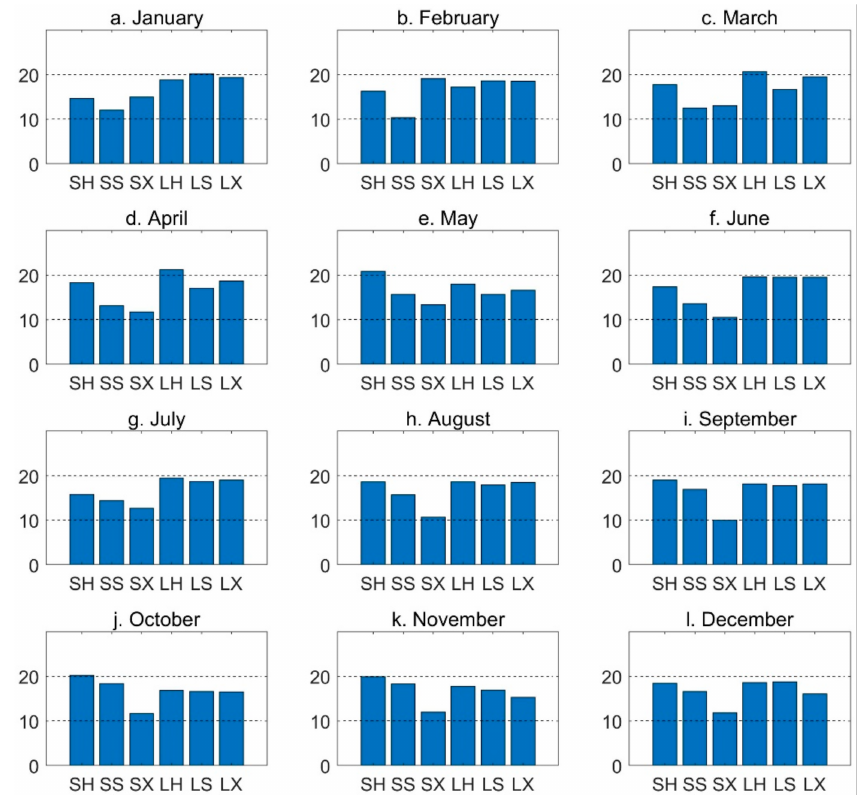
Figure 8. BMA weights (%) computed for runoff records in different